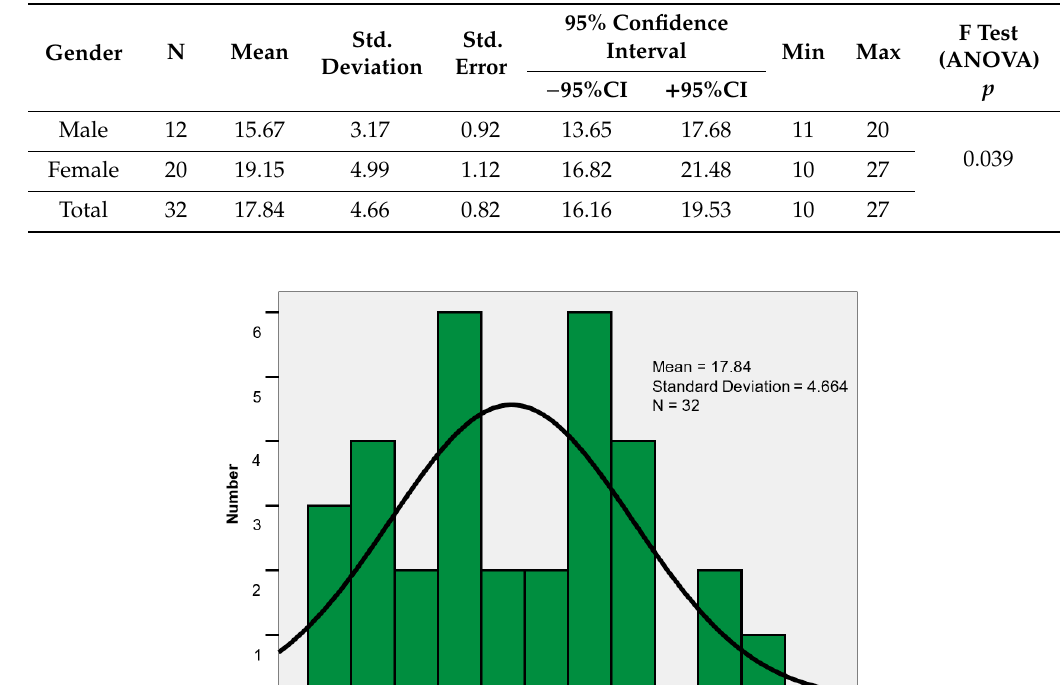
Table 7. Descriptive statistics of physical functioning score by gender.